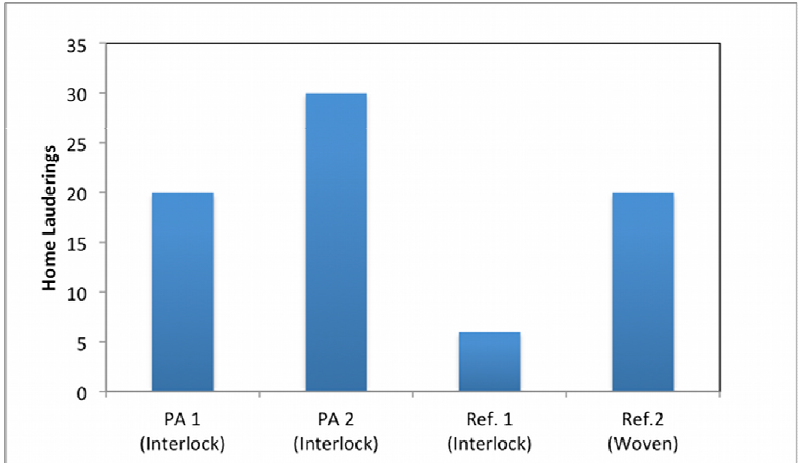
Figure 6. Comparison of durability of treated fabrics with commercial reference samples by the drop